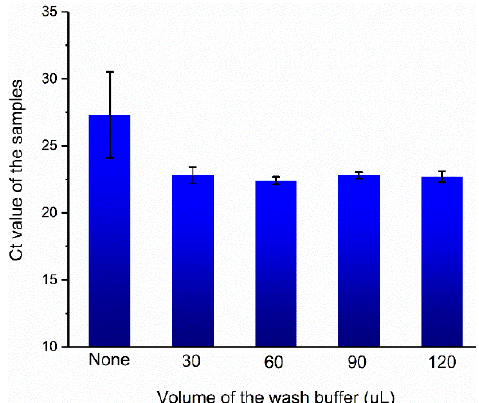
Figure 6. Results of relationship between washing volume and cycle threshold (Ct) values of amplification.